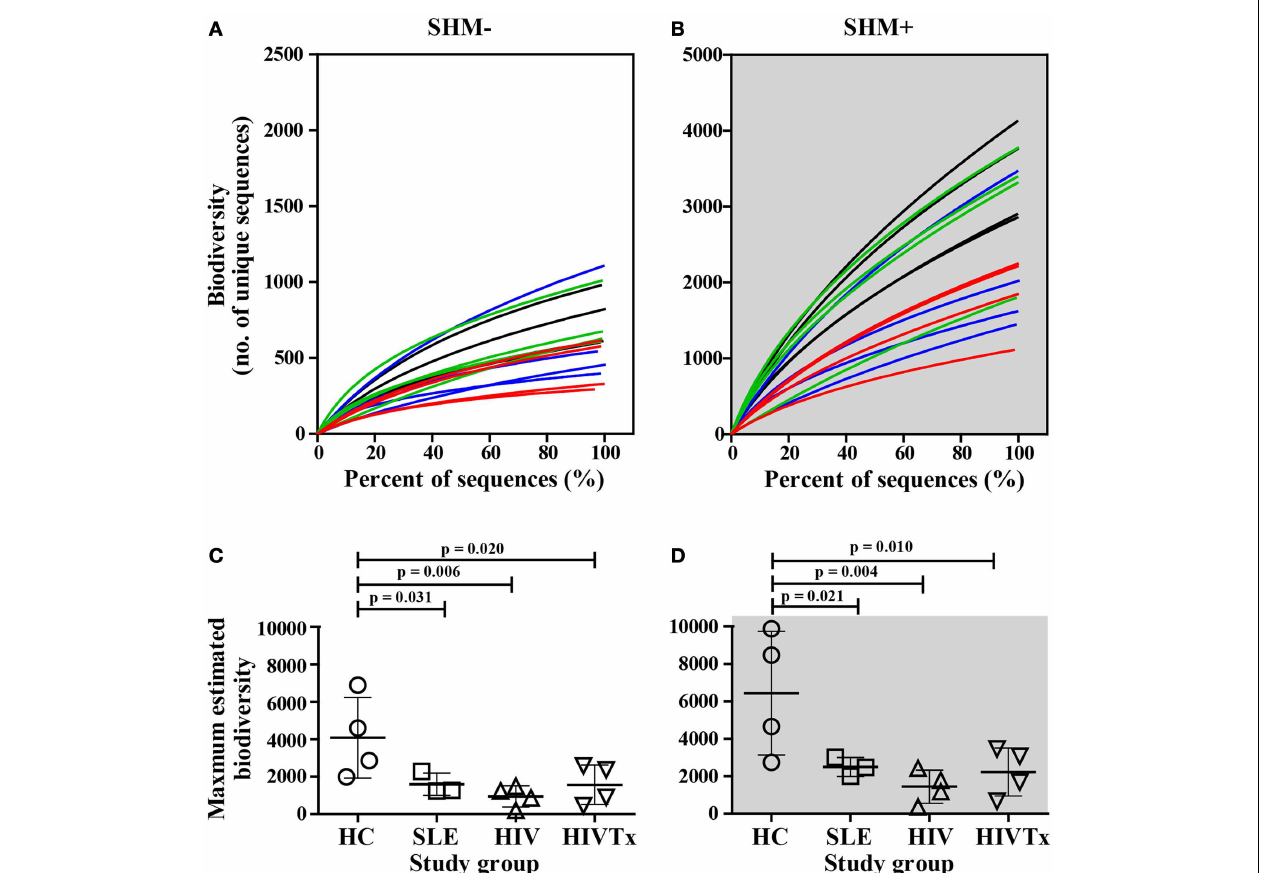
IGHM CDRH3 biodiversity in input IgM B cells without (C) or with (D) was significantly lower in SLE (SHM − , p = 0.031; SHM + , p = 0.021), HIV (SHM − , p = 0.006; SHM + , p = 0.004), and HIVTx (SHM − , p = 0.020; SHM + , p = 0.010) in comparison with HC. ART failed to normalize IGHM CDRH3 biodiversity in SHM − or SHM + IGHV CDRH3 repertoire in HIV-infected subjects (HIVTx vs. HIV, p >